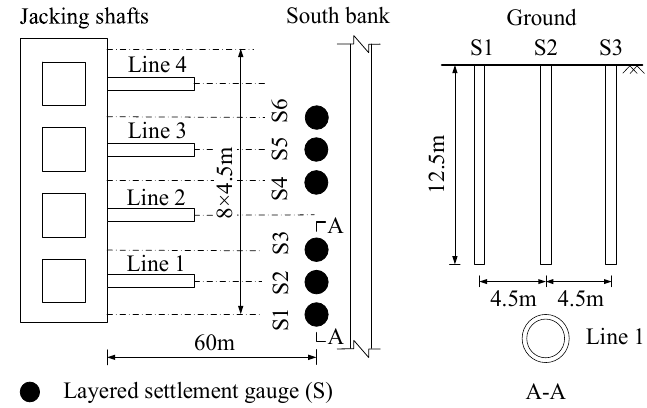
Figure 8. Geotechnical profiles and soil properties of the construction site (based on Shen et al. [71]).